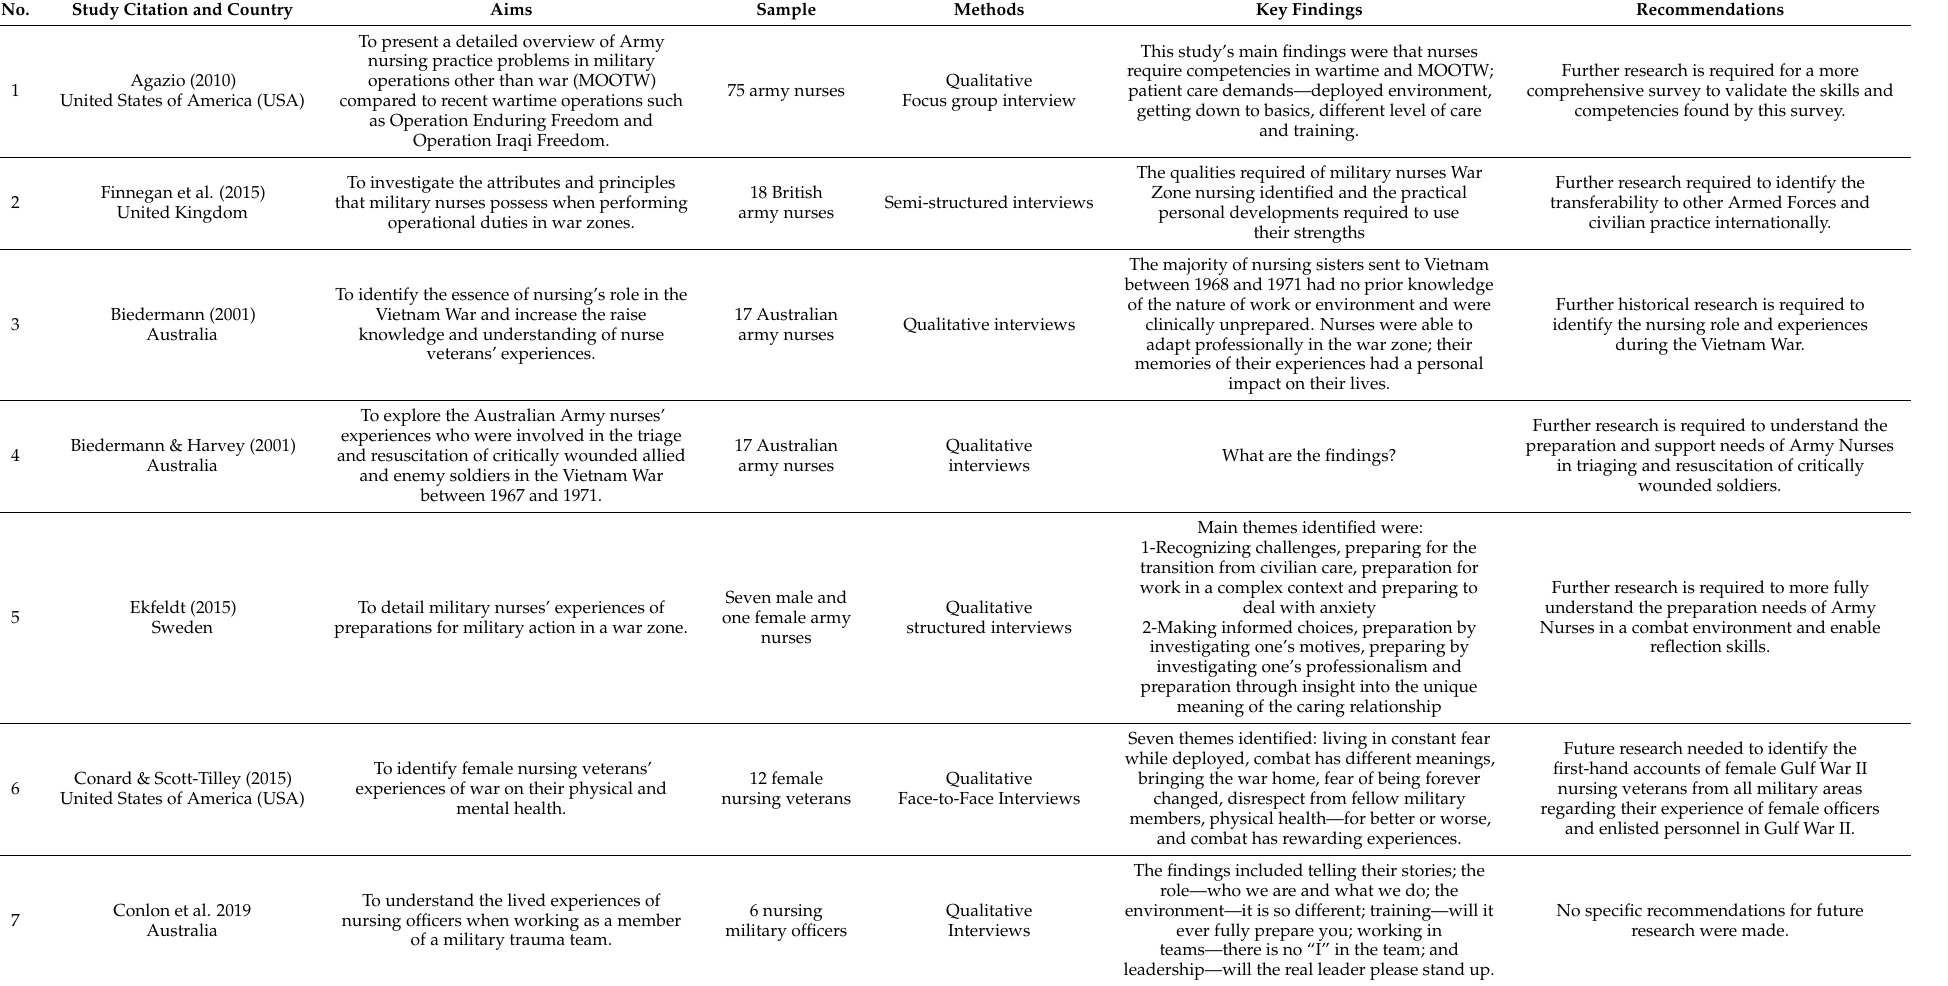
Table 1. Studies included in the systematic review ( n =